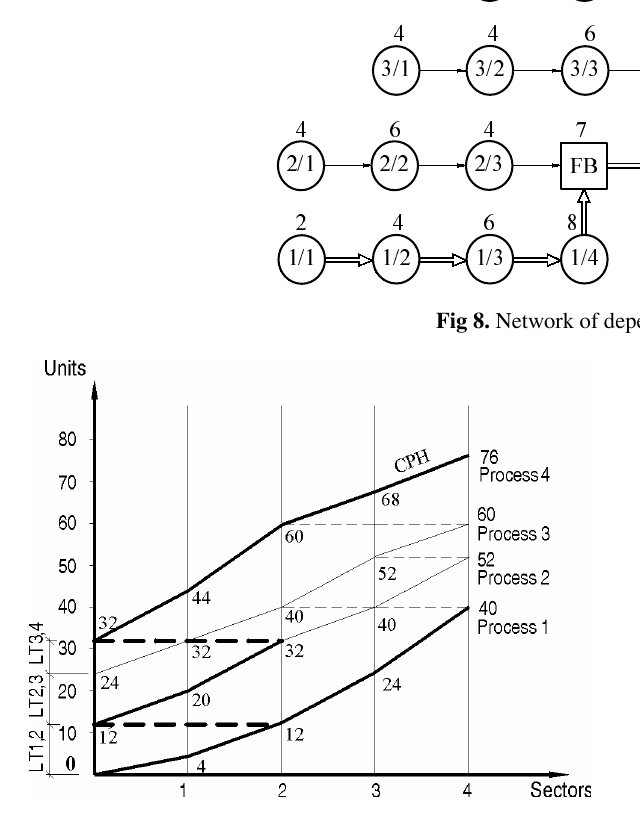
Fig 11. Cyclogram with critical chain and time buffers (Units, Process 4,